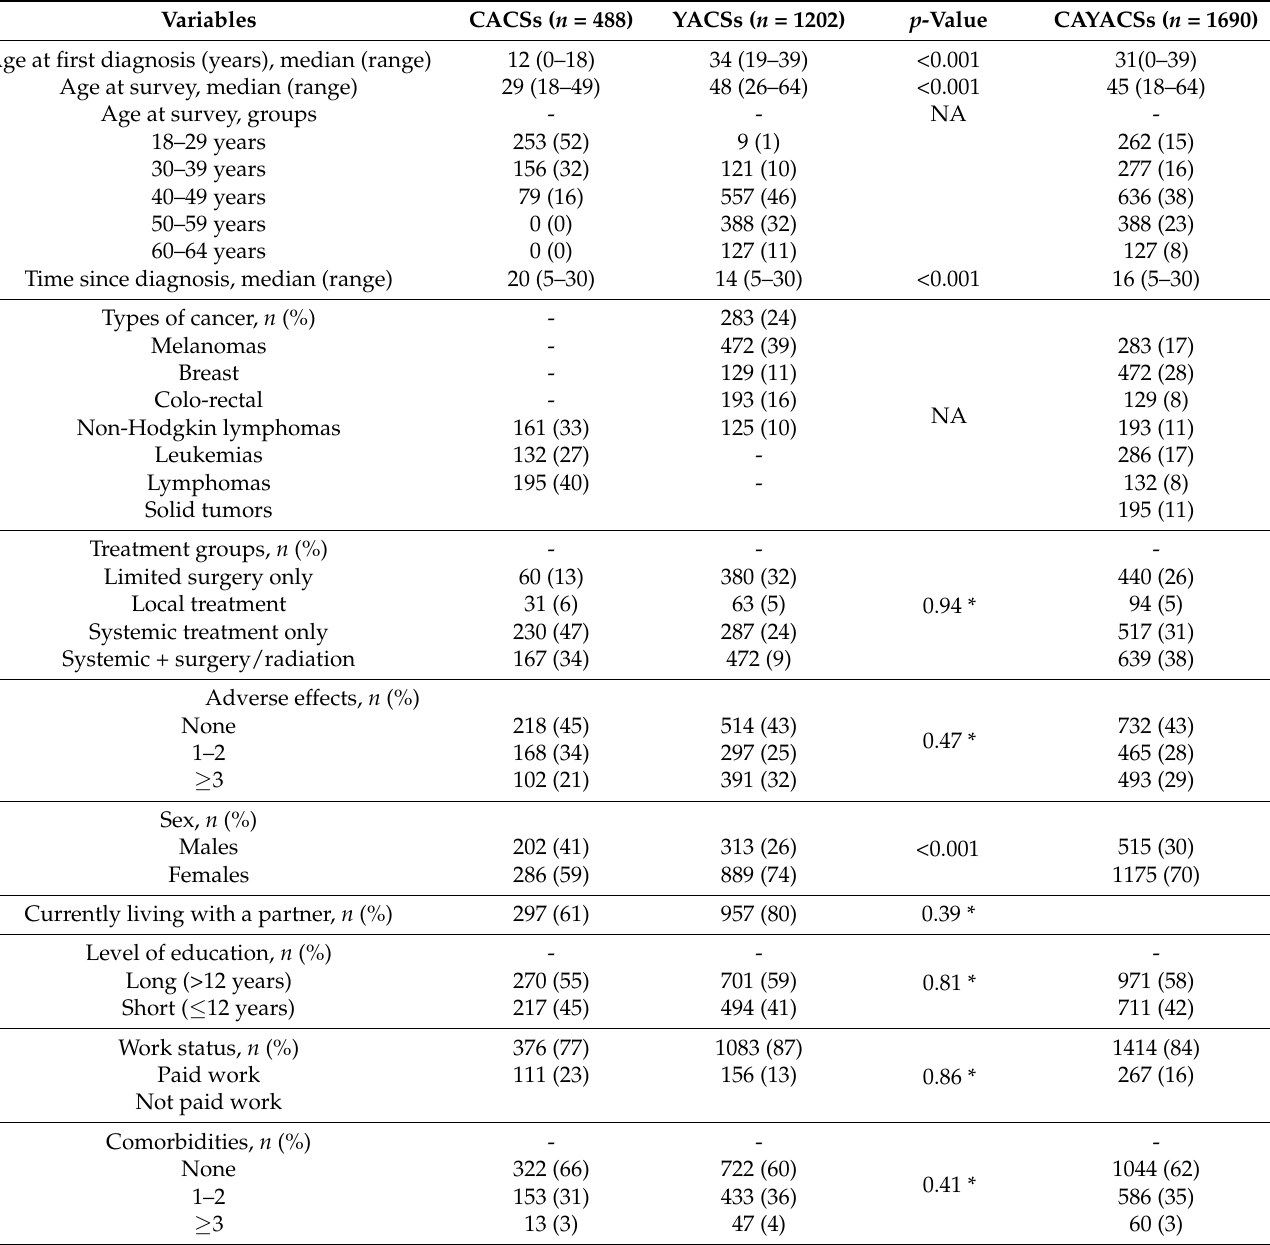
Table 1. Characteristics of childhood and adolescent (CACSs) and young adult (YACSs) cancer survivors and their total (CAYACSs) at